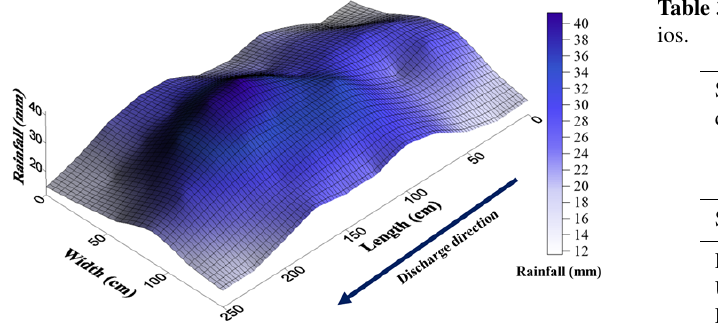
Figure 9. Rainfall distribution graph.